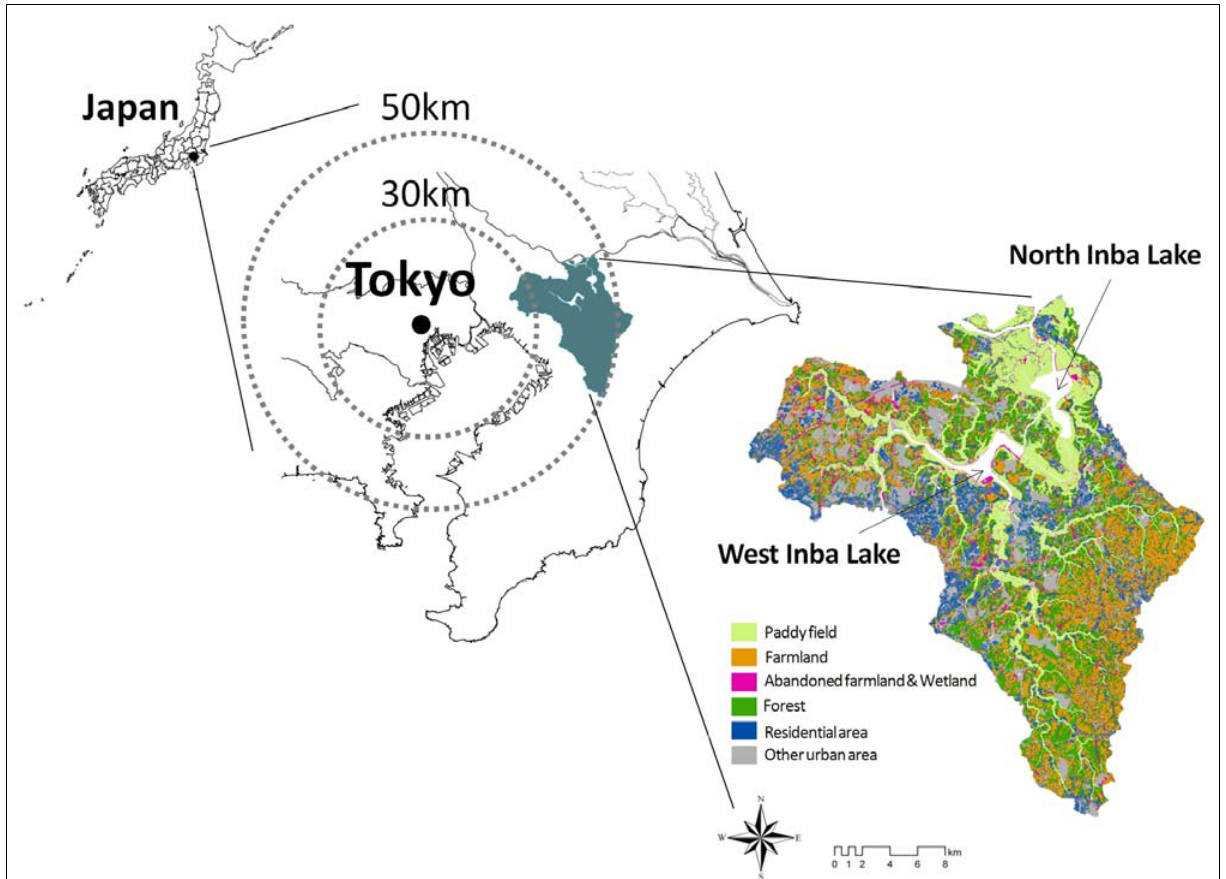
Figure 3. The location and land cover of the Inba watershed in relation to central